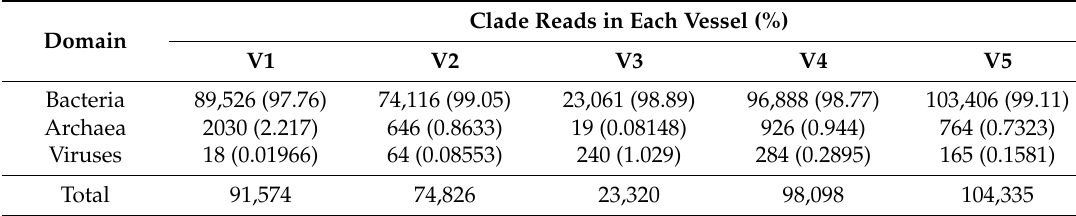
Table 2. Reads mapped to the three domains of